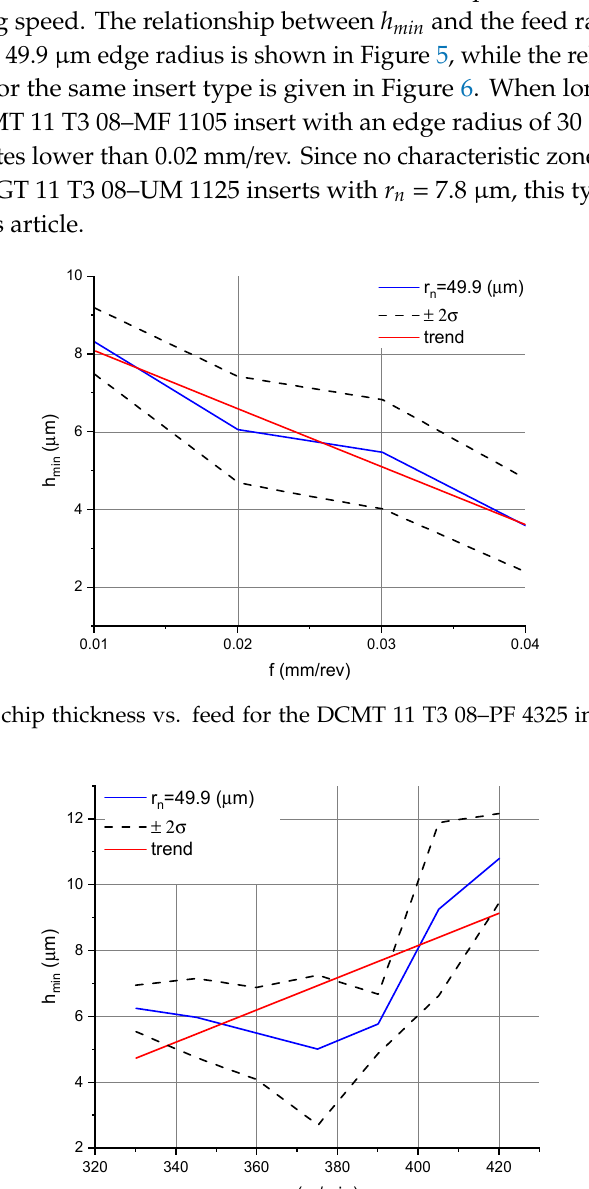
Figure 6. Minimum chip thickness vs. cutting speed for the DCMT 11 T3 08–PF 4325 insert with a 49.9 µm edge radius.